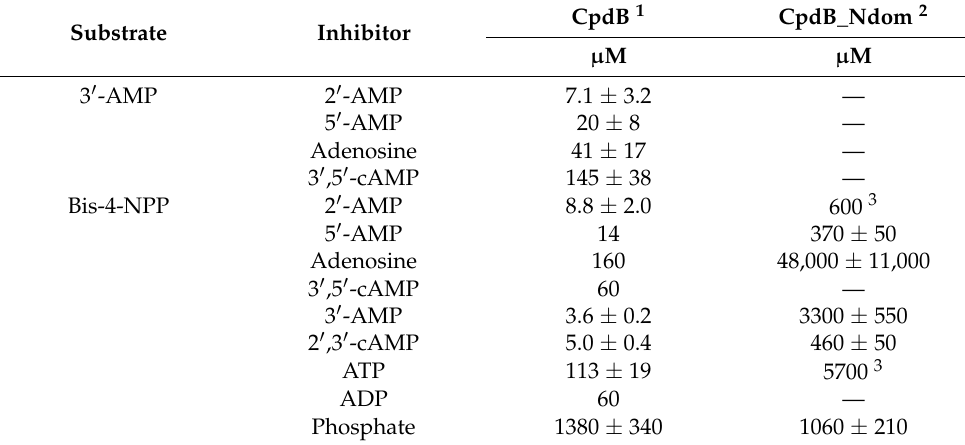
Table 2. Inhibition constants ( K i ) of alternative substrates and non-substrates of mature CpdB and CpdB_Ndom. The values were obtained during the analyses of substrate saturation curves with(out) inhibitor by the global fit of the equation to the experimental data. Whenever the results are shown as mean values ± standard deviations, they correspond to three independent experiments. CpdB 1 CpdB_Ndom 2 Substrate Inhibitor µ M µ M 3 (cid:48) -AMP 2 (cid:48) -AMP 7.1 ± 3.2 — 5 (cid:48) -AMP 20 ± 8 — Adenosine 41 ± 17 — 3 (cid:48) ,5 (cid:48) -cAMP 145 ± 38 — Bis-4-NPP 2 (cid:48) -AMP 8.8 ± 2.0 600 3 5 (cid:48) -AMP 14 370 ± 50 Adenosine 160 48,000 ± 11,000 3 (cid:48) ,5 (cid:48) -cAMP 60 — 3 (cid:48) -AMP 3.6 ± 0.2 3300 ± 550 2 (cid:48) ,3 (cid:48) -cAMP 5.0 ± 0.4 460 ± 50 ATP 113 ± 19 5700 3 ADP 60 — Phosphate 1380 ± 340 1060 ±